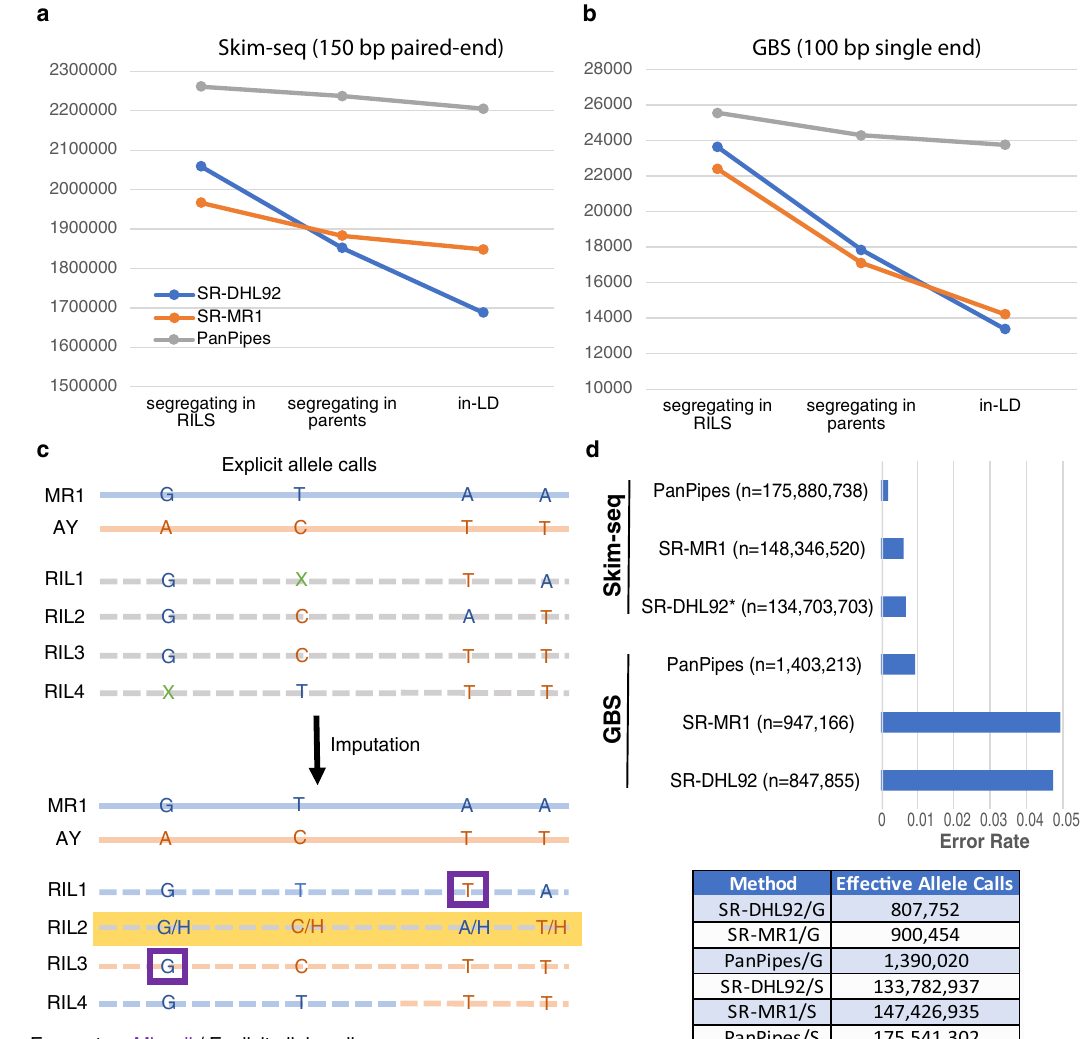
Fig. 3 | Genotyping ef fi cacy of biparental population across methods. Three methods used were (1) a graph-based approach using the pangenome — PanPipes, (2) single-reference approach using newly developed MR1 assembly — SR-MR1, and (3) a single-reference approach using currently available DHL92 assembly — SR- DHL92. a For skim-seq chemistry, the three methods are compared in terms of starting variants and variants remaining after various fi ltering criteria described in text. b Comparableto a butforGBSchemistry. c Errorrateassessmentisillustrated